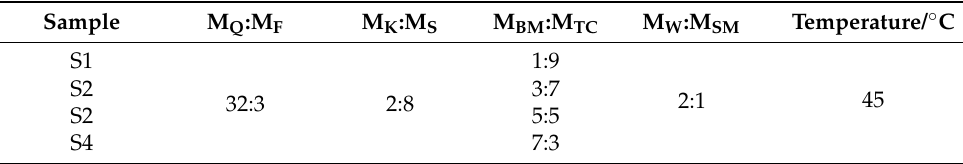
Table 2. Simulation experiments